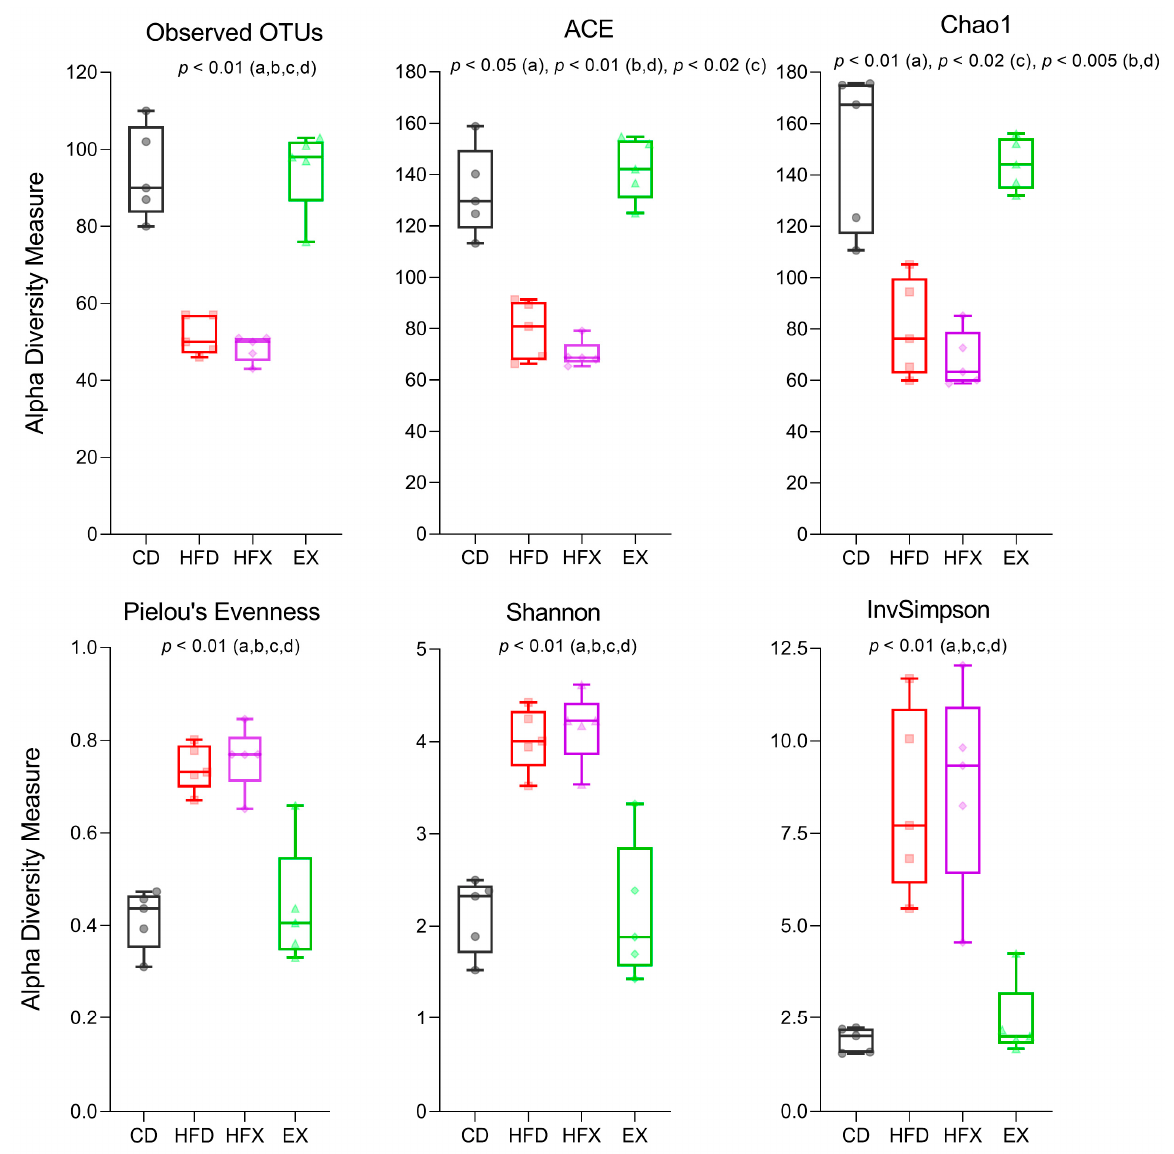
Figure 2. Alpha diversity indices for species richness (observed OTUs, ACE, Chao1), evenness (Pielou’s evenness), and diversity (Shannon, inverse Simpson). Kruskal–Wallis test and two-stage linear step-up procedure of Benjamini, Krieger, and Yekutieli tests for multiple comparisons were performed for median comparison across groups. Boxes denote the interquartile ranges, lines indicate medians, and whiskers demarcate the ranges. p -values are FDR corrected. a: CD/HFD, b: CD/HFX, c: HFD/EX, d: HFX/EX.